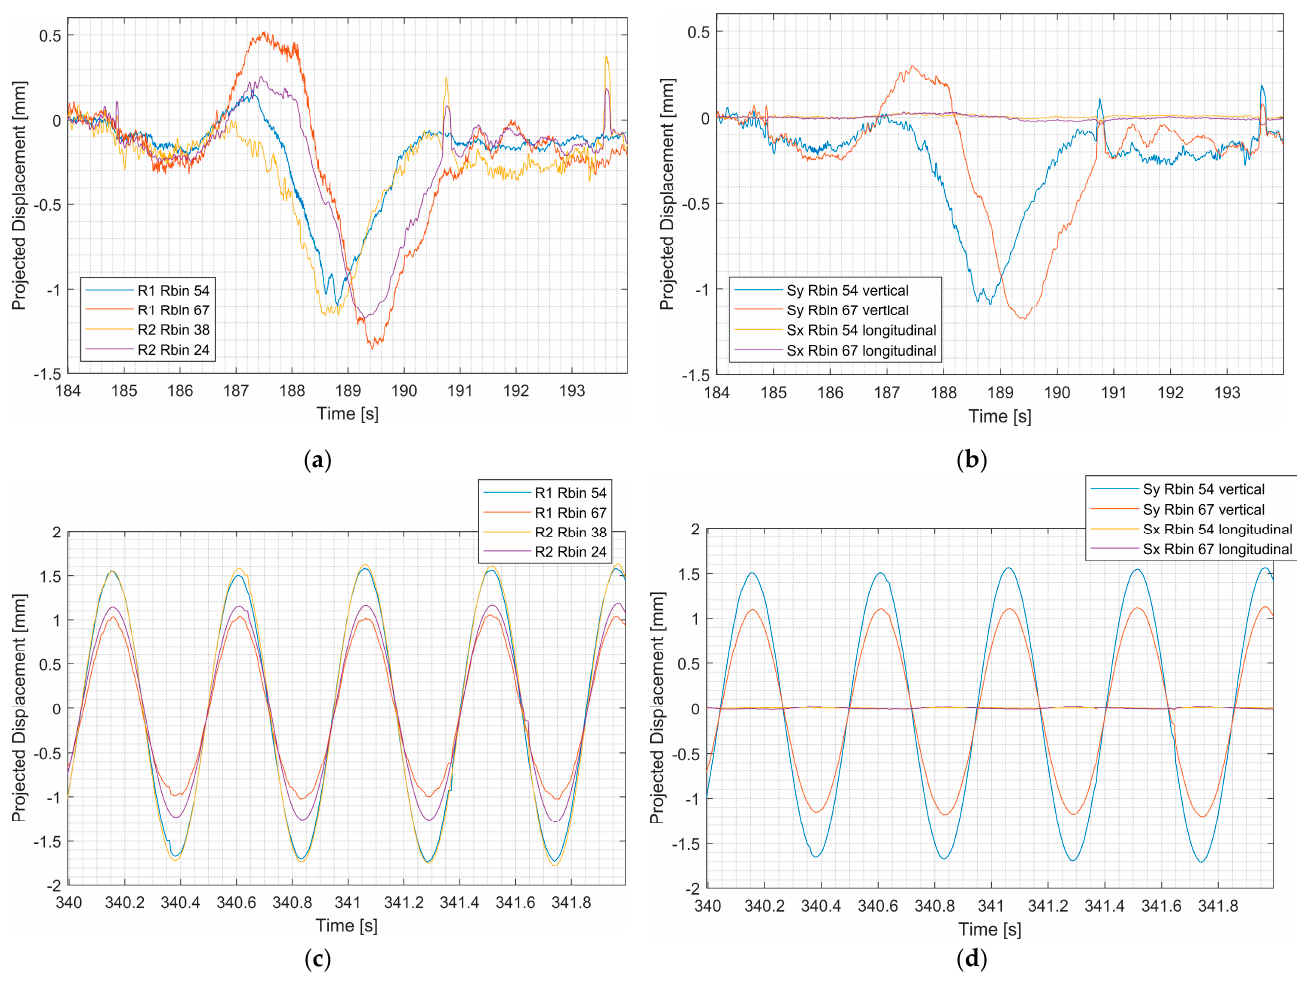
Figure 23. Displacements, including the quasi static component demonstrated on two crossbeams (the first one corresponds to Rbins R1 54 and R2 38, and the second one to Rbins R1 67 and R2 24): at the top during the passage of the vehicle in the direction from M ě lice to Valy; at the bottom caused by the regular pace of a group of pedestrians; ( a , c ) comparison of separately evaluated vertical displacements using Formula (1) measured by radars R1 and R2; ( b , d ) longitudinal and vertical displacements calculated by combination of both radar measurements (4). The Rbin numbers correspond to the R1